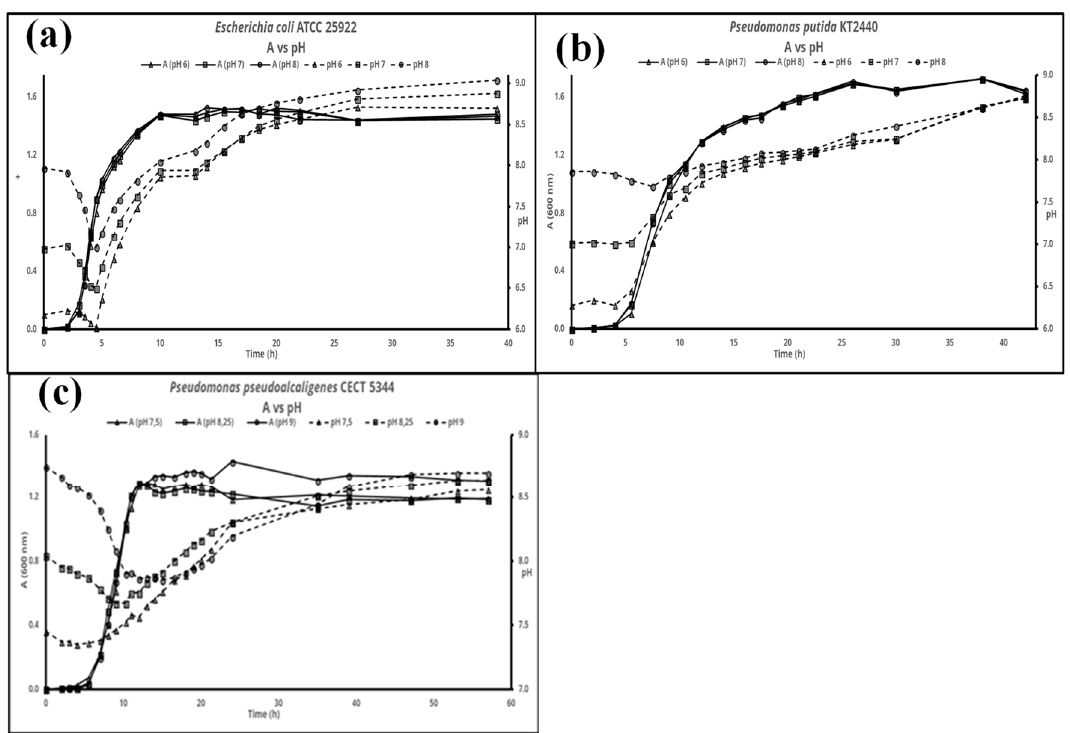
Figure 1. Evolution of the pH during the bacterial growth in LB media at different initial pHs: ( a ) E. coli ATCC 25922, ( b ) P. putida KT2440 and ( c ) P. pseudoalcaligenes CECT 5344 were inoculated at the indicated pHs and cell growth (solid lines) an pH of the media (dashed lines) were measured along the experiments, that were run in triplicate. A representative experiment is shown here.